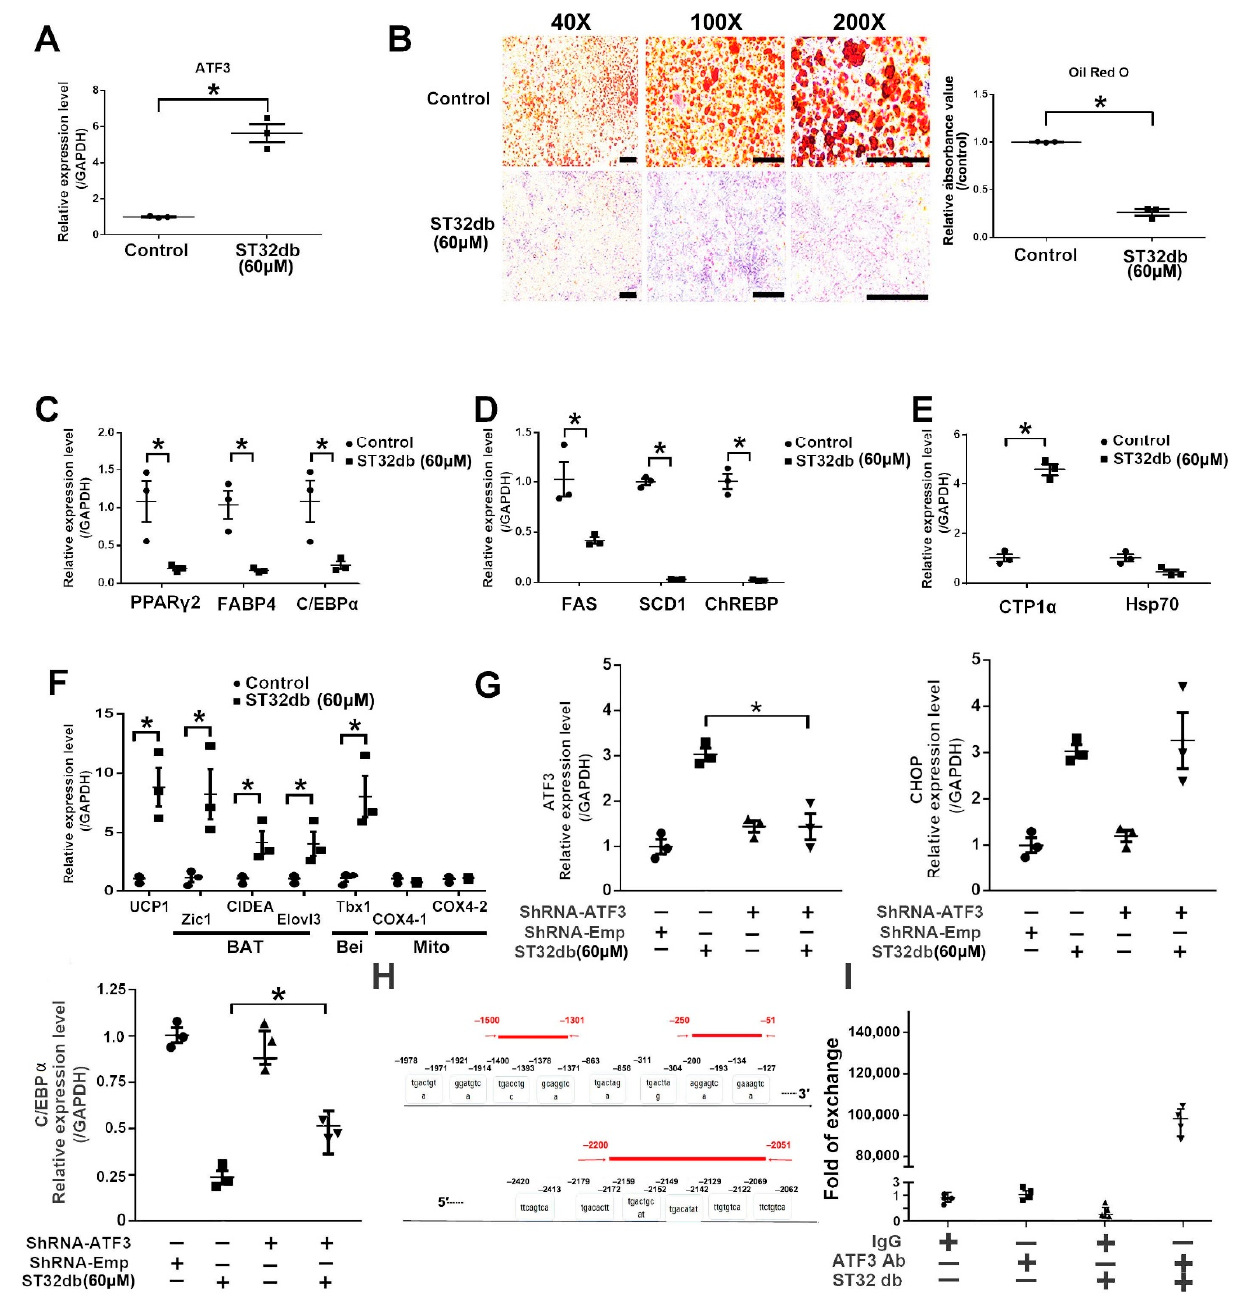
Figure 7. ST32db treatment of 3T3-L1 adipocytes suppresses lipogenesis/adipogenesis through the ATF3 pathway to directly inhibit C/EBP α expression and indirectly inhibit the CHOP pathway. ( A ) ATF3 expression after ST32db treatment. ( B ) Representative photographs and statistical results of Oil Red O staining of 3T3-L1 cells with and without ST32db treatment. ( C – F ) Real-time PCR analysis results of mRNA levels of adipogenic, lipogenic, β -oxidation ( β -oxi), brown (BAT), beige (Bei), and mitochondrial (Mito) genes, normalized to GAPDH in 3T3-L1 cells with and without ST32db treatment. ( G ) Expression levels of ATF3, CHOP, and C/EBP α in 3T3-L1 cells after 6 h of ST32db treatment. ( H ) Sequence of three potential binding sites for ATF3 in C/EBP α promoter: site 1 ( − 2200/ − 2051), site 2 ( − 1500/ − 1301), and site 3 ( − 250/ − 51) of C/EBP α locus. ( I ) Results of ChIP experiments with ATF3-specific antibody and primers to amplify region site 2 of C/EBP α locus, which contained one predicted ATF3 binding site in 3T3-L1 preadipocytes. Experiments were conducted in triplicate. Data are the mean ± SEM ( n = 3); * p < 0.05. Scale bar for B: Each line segment is equal to 100 µ